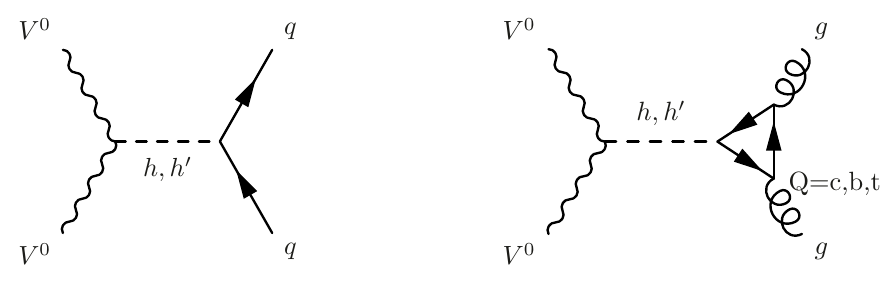
Figure 3 . The leading diagrams mediated by h and h